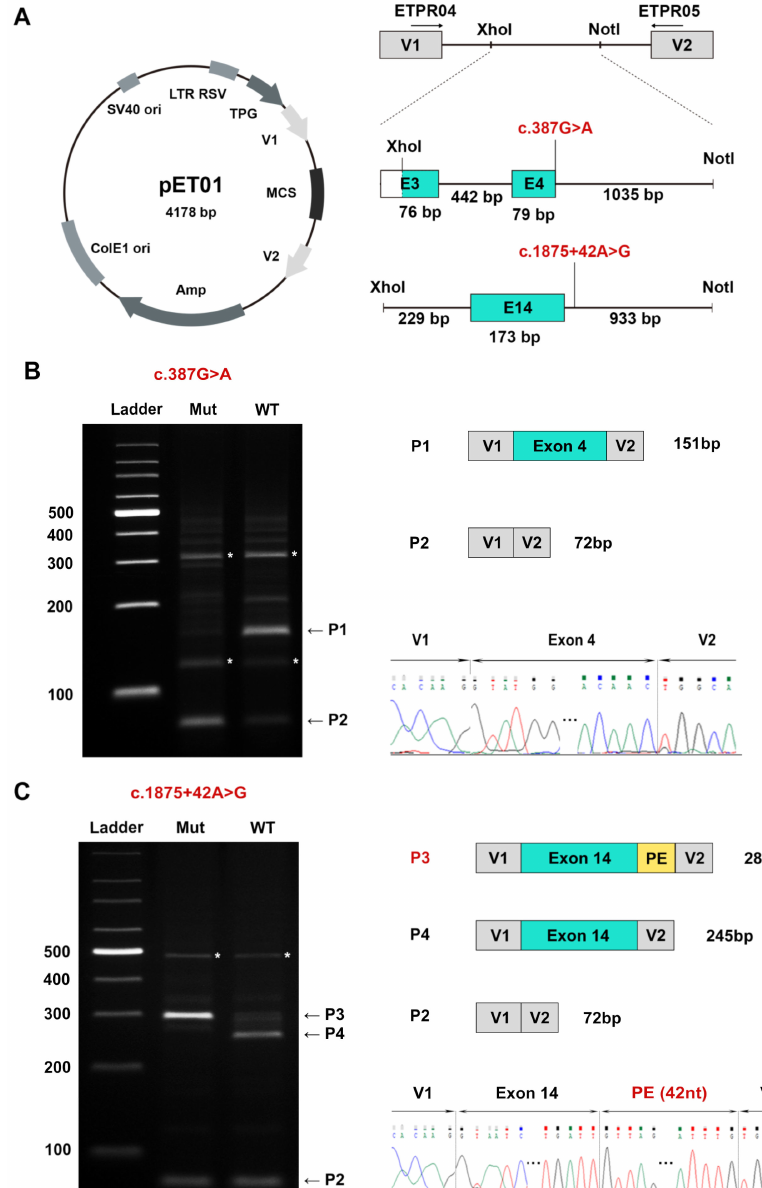
Figure 1. Results of minigene assays for variants c.387G>A and c.1875+42A>G identified in the KIF11 gene. The target fragments were cloned into the multiple cloning site (MCS) of pET01 between